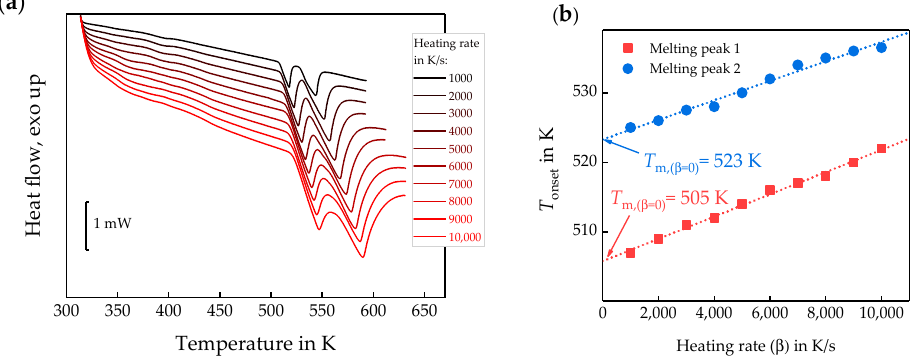
Figure 10a. The extrapolated peak onset temperatures are plotted versus heating rate in Figure 10b.